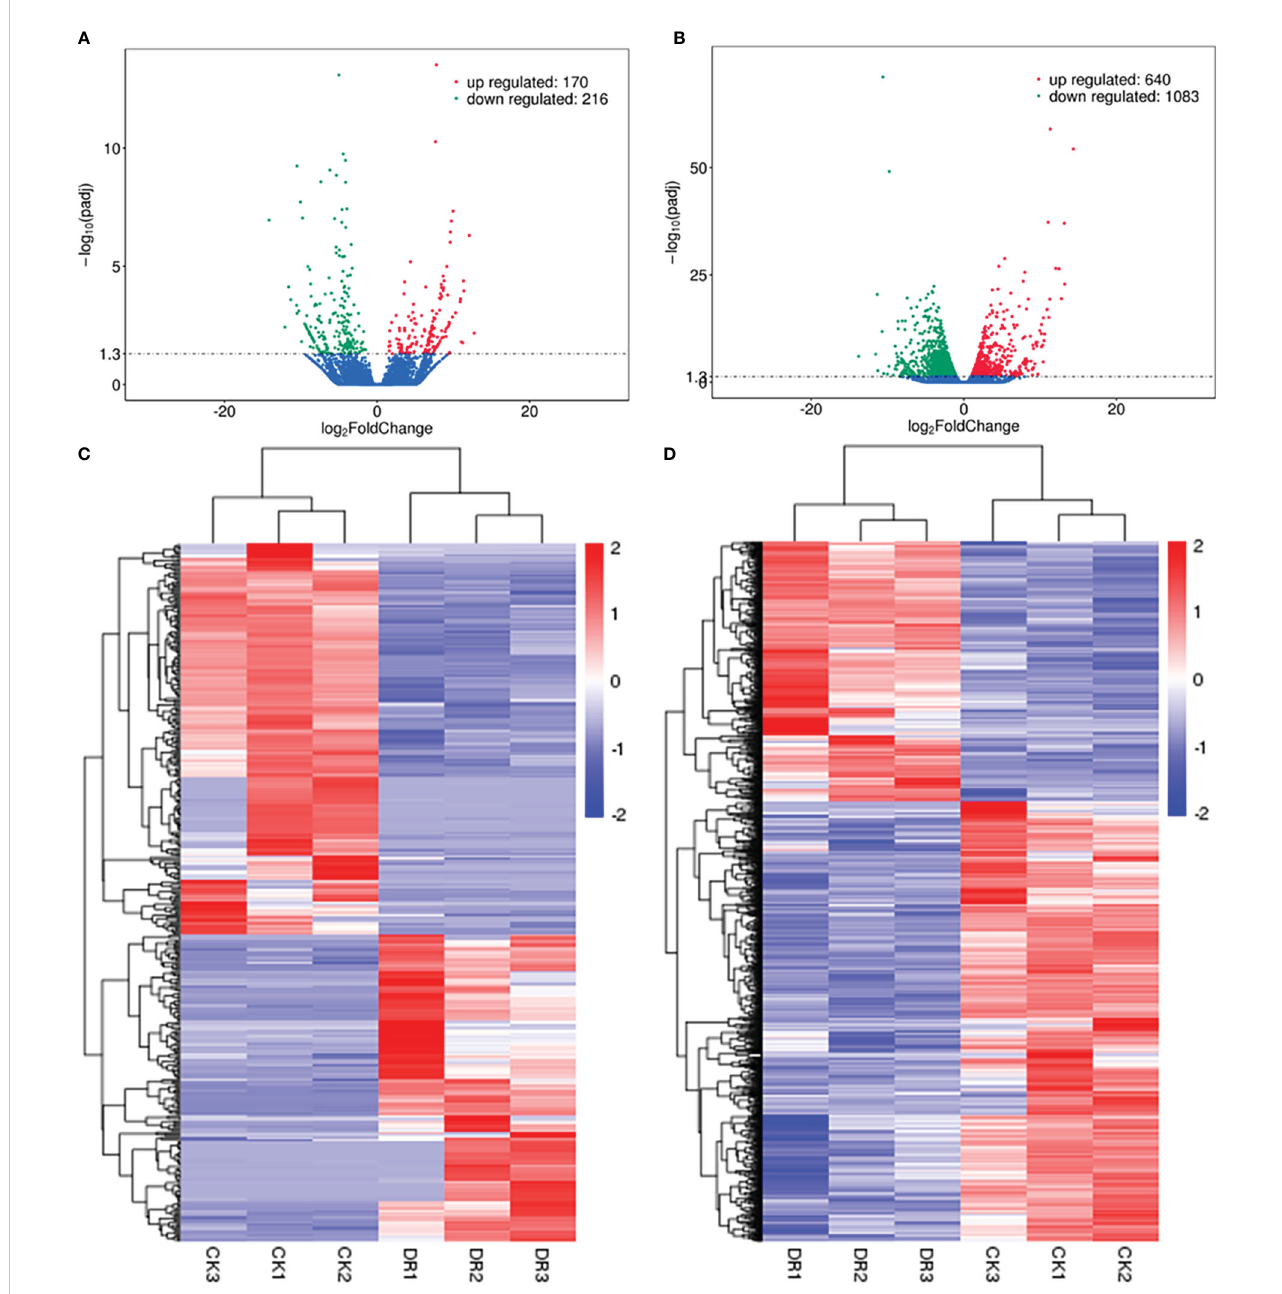
FIGURE 3 Analysis of DElncRNAs. (A) Volcano plot showing DElncRNAs. (B) Volcano plot showing DEmRNAs. (C) Heatmap for the DElncRNAs. (D) Heatmap for the